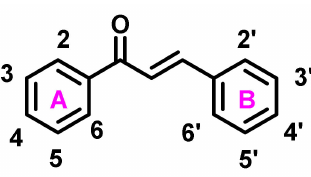
Figure 3. Structure and numbering of chalcone